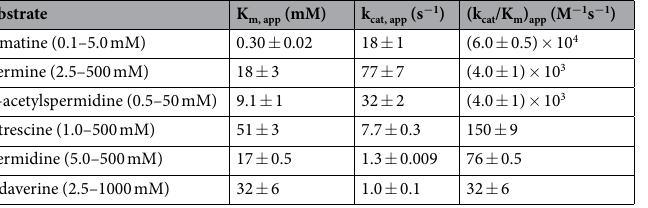
Table 3. Steady-state Kinetic Constants for Amine Substrates at a Fixed Initial Concentration of Acetyl- CoA a,b . a Kinetic constants are reported as ± standard error (n = 3). b Reaction conditions − 300 mM Tris-HCl pH 8.5, 150 µ M DTNB, 500 μ M acetyl-CoA, and varying concentration of amine substrate. c he range of amine